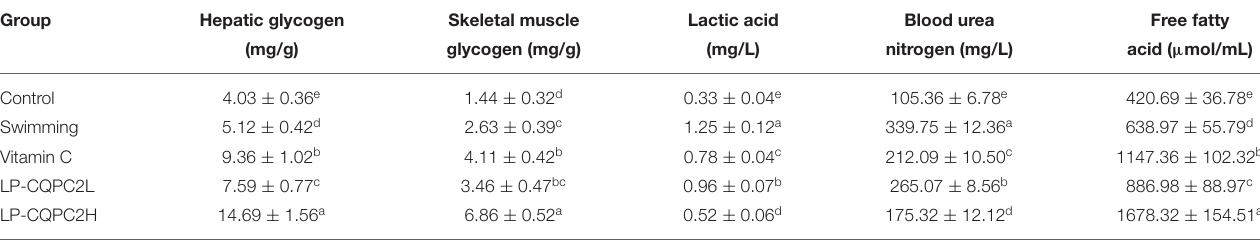
TABLE 2 | Hepatic glycogen, skeletal muscle glycogen, lactic acid, blood urea nitrogen and free fatty acid levels of mouse in each group. Group